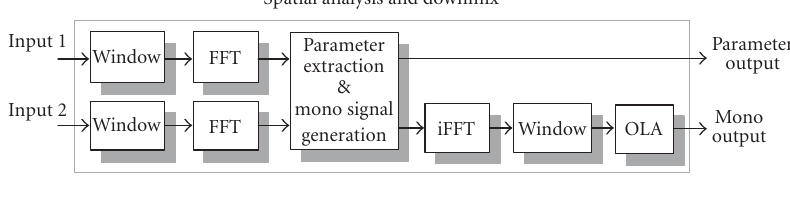
Figure 3: Spatial analysis and downmix stage of the